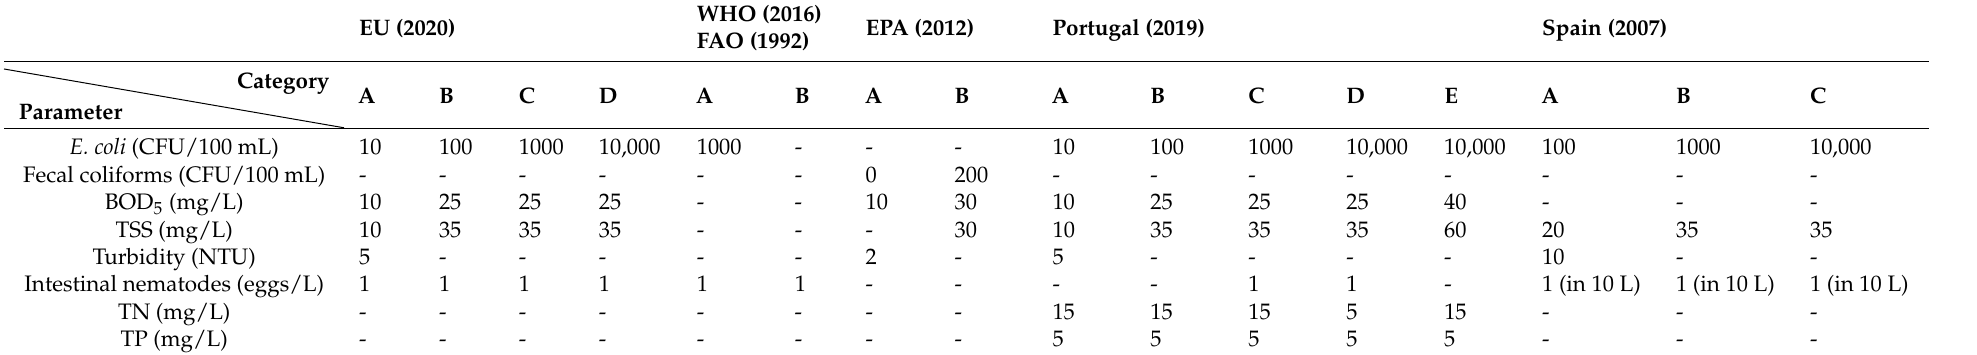
Table 1. Reclaimed water quality guidelines for agricultural reuse for EU, WHO, FAO, EPA, Portugal and